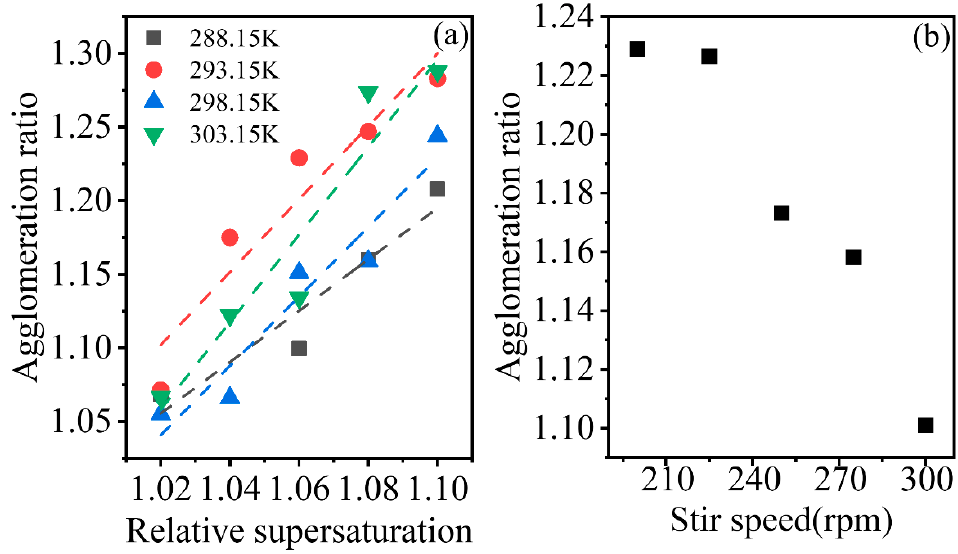
Figure 10. Effects of the initial supersaturation level ( a ) and stirrer speed ( b ) on the agglomeration ratio.